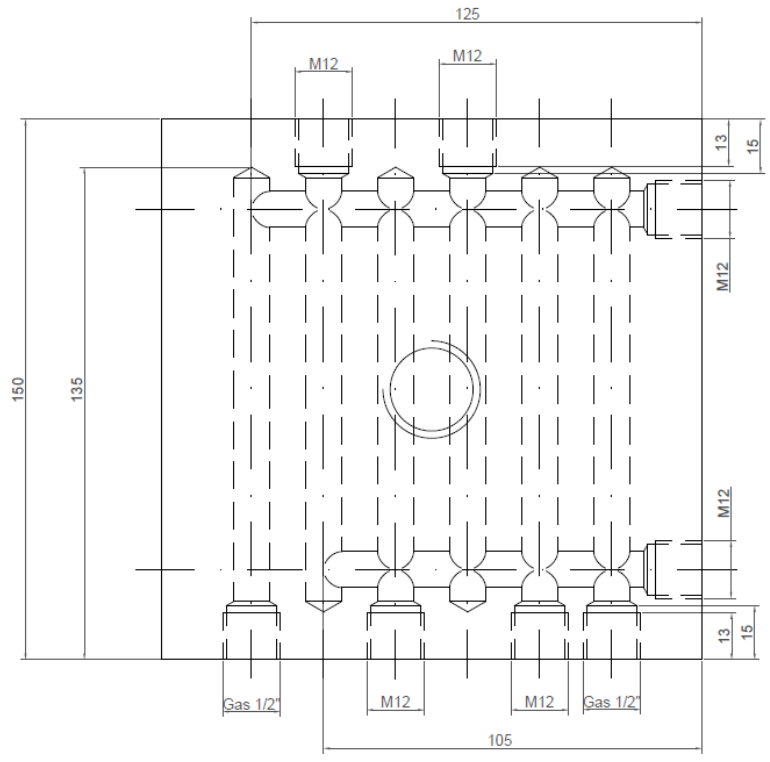
Figure 3. Die demonstrator sketch with the cooling system.